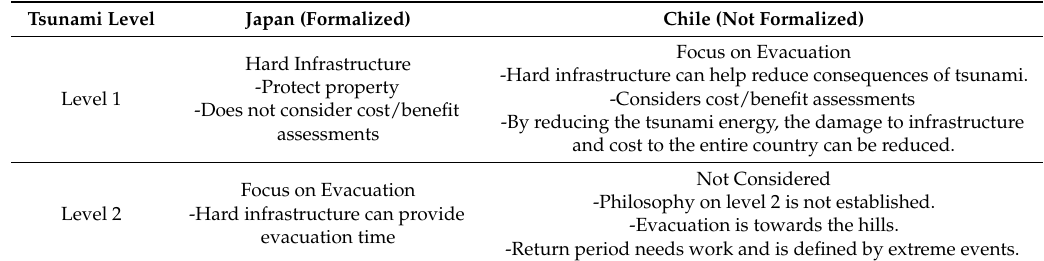
Table 4. Comparative summary of defence strategies against tsunamis in Japan and